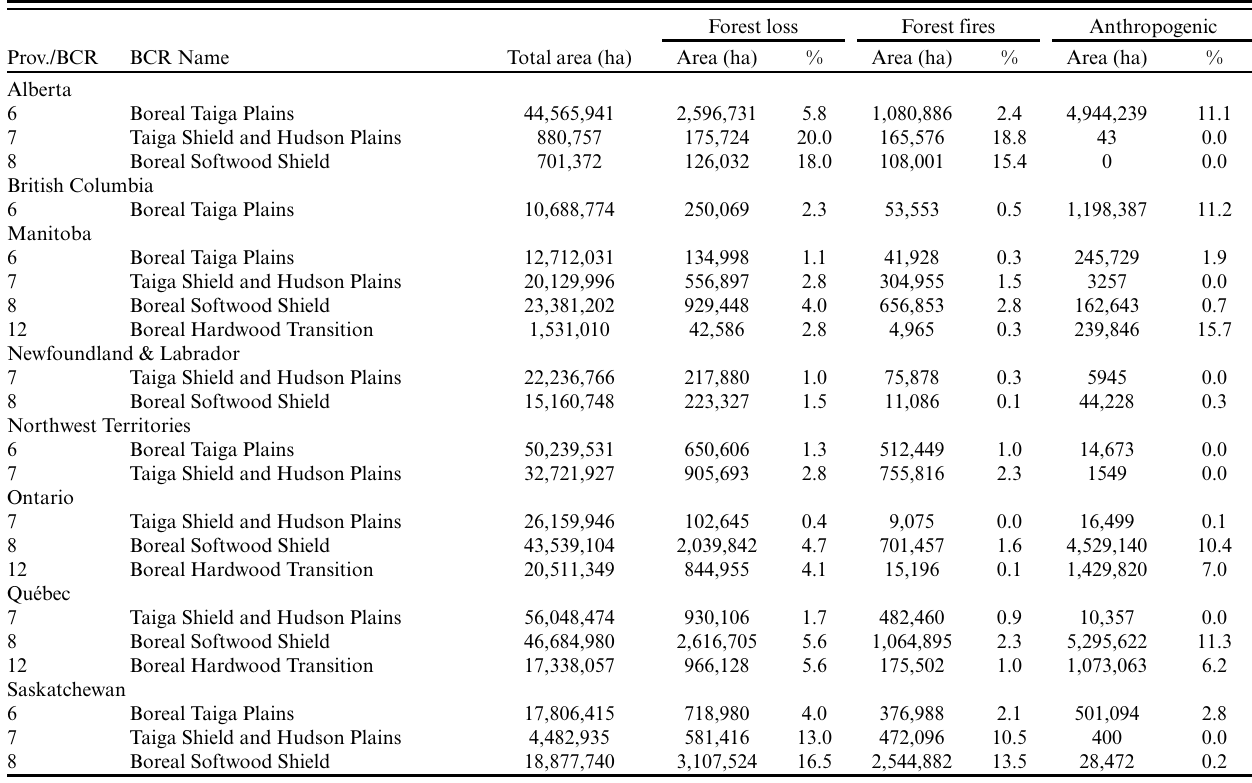
Table 1 . Distribution of assigned and unassigned North American Breeding Bird Survey routes and study area extent based on the portion of boreal Canada for which anthropogenic disturbance data (Pasher et al. 2013) are available. BCR indicates bird conservation